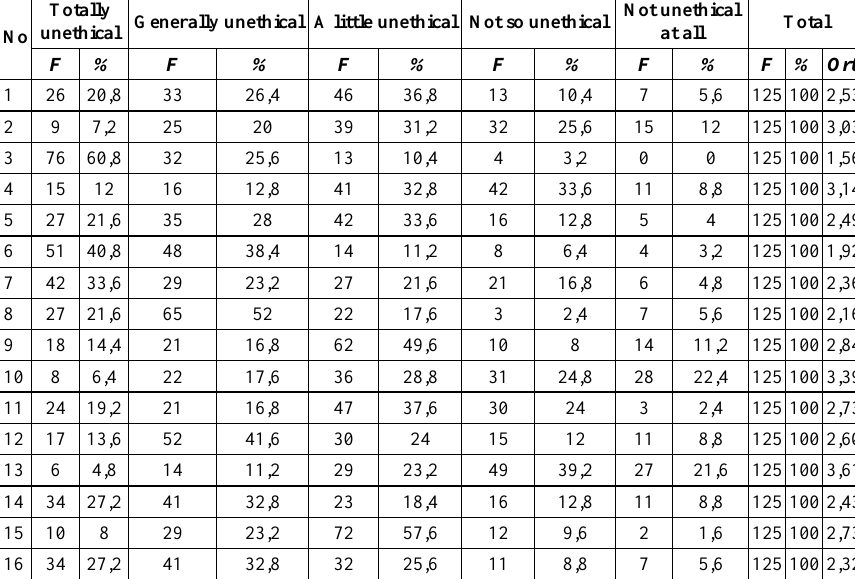
Table 4. Ethical perceptions of students regarding their own